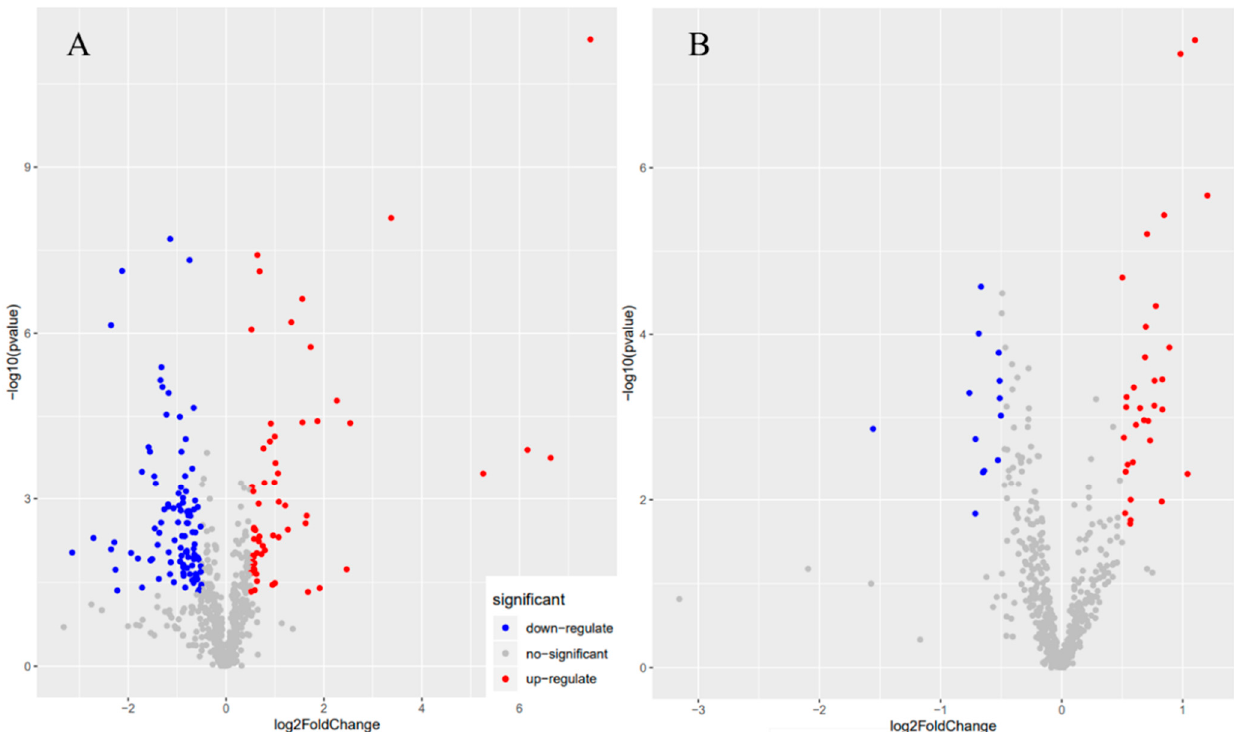
Figure 4. Volcano plot (28 March and 13 April). ( A ): Positive ion mass spectrum; ( B ): Negative ion mass spectrum. Each circle point represents a variable (metabolite), the red circle points represent all variables that increased significantly after dormancy release, the blue circle points represent all variables that decreased significantly after dormancy release, and the grey circle points represent variables with no significant difference (28 March and 13 April).